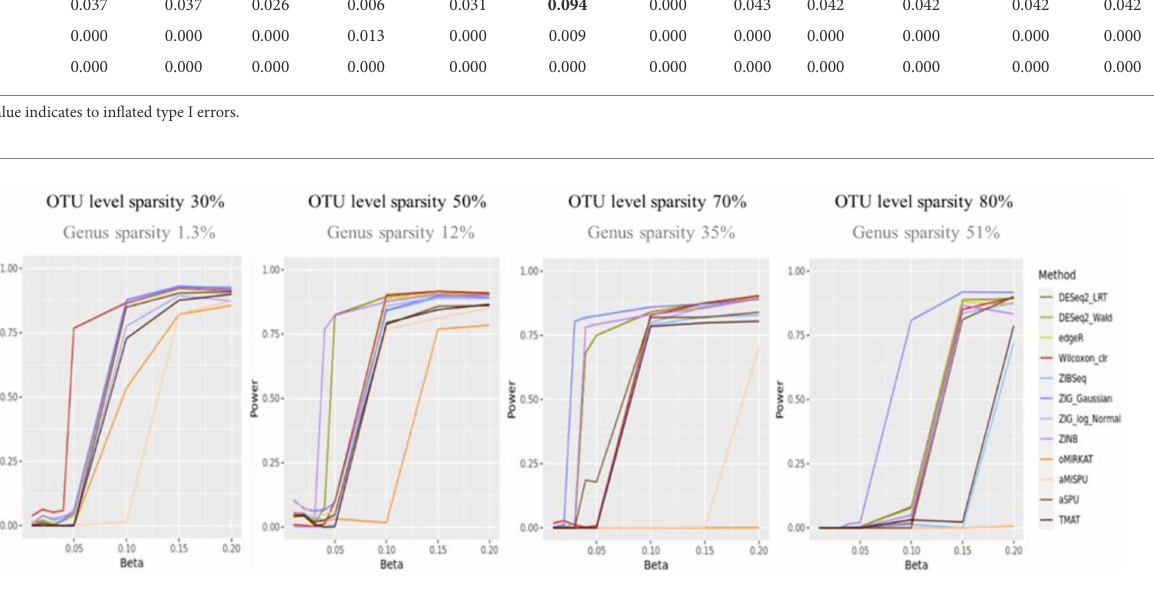
TABLE 2 Type 1 error rates of individual statistical methods. Sparsity DESeq2 DESeq2 LRT Wald